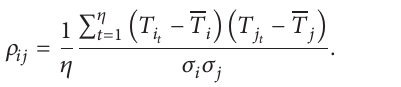
it possible for the readers to implement their own methods through the combination of the proposed models according to their own